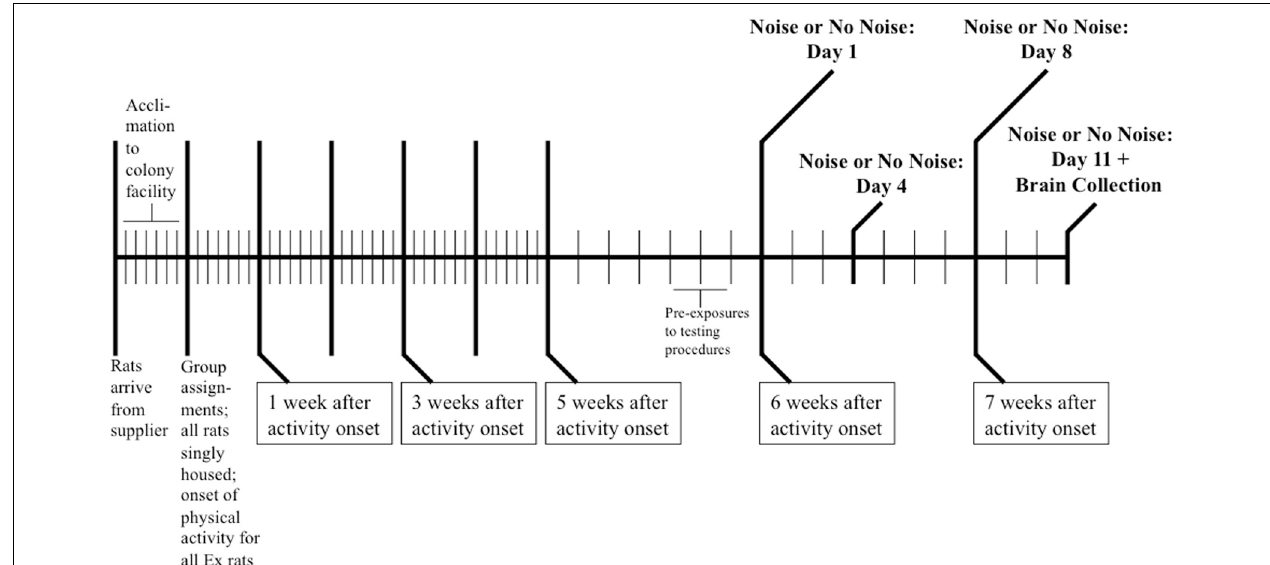
FIGURE 1 | Schematic depicting the experimental design used in the Sasse et al. (2008) study to generate the brain tissue samples utilized in the present study . Following a 7-day acclimation period to the colony facility, rats were assigned to one of six groups matched for body weight ( n = 8/group) and individually housed. Half of the rats were given unrestricted voluntary access to running wheels in their home cages (Ex) while the remaining animals lived in similar cages without running wheels under sedentary conditions (Sed) for 6 weeks. Rats were then exposed to 11 consecutive daily 30min 98dB noise stress (Ex- or Sed-Repeated Noise;